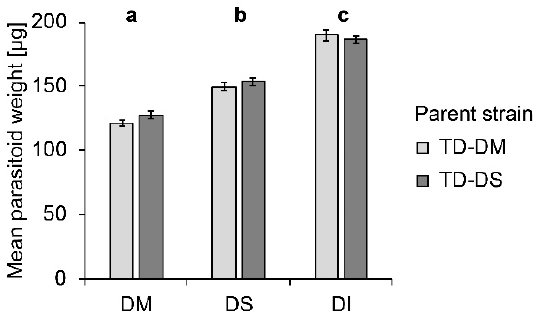
Figure 2. Mean (± SE) weight of female offspring produced by T. drosophilae from a strain reared for >30 generations on D. melanogaster (light grey) or on D. suzukii (dark grey) on different host species under no-choice conditions. DM: D. melanogaster ; DS: D. suzukii ; DI: D. immigrans . Different letters above bars indicate significant differences between host species at the 5% p-level (ANOVA followed by Tuckey post hoc tests). No significant differences between strains were detected (Mann–Whitney U test).